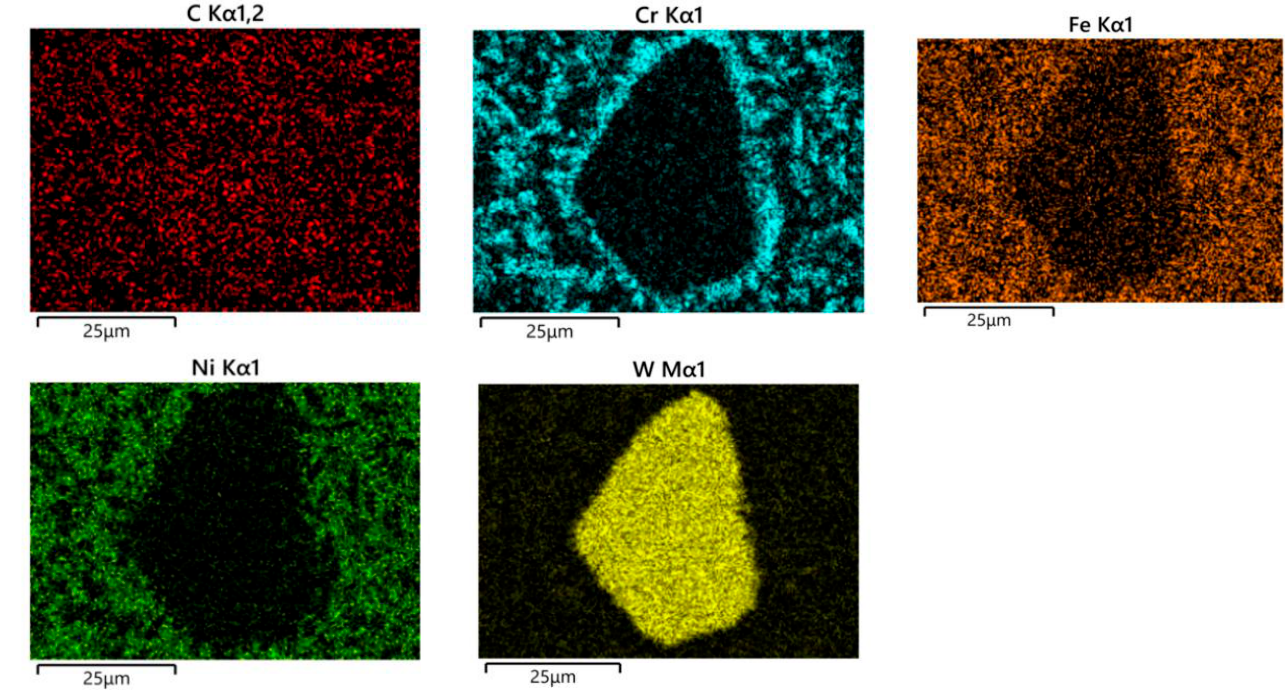
Figure 9. Results of face scanning.